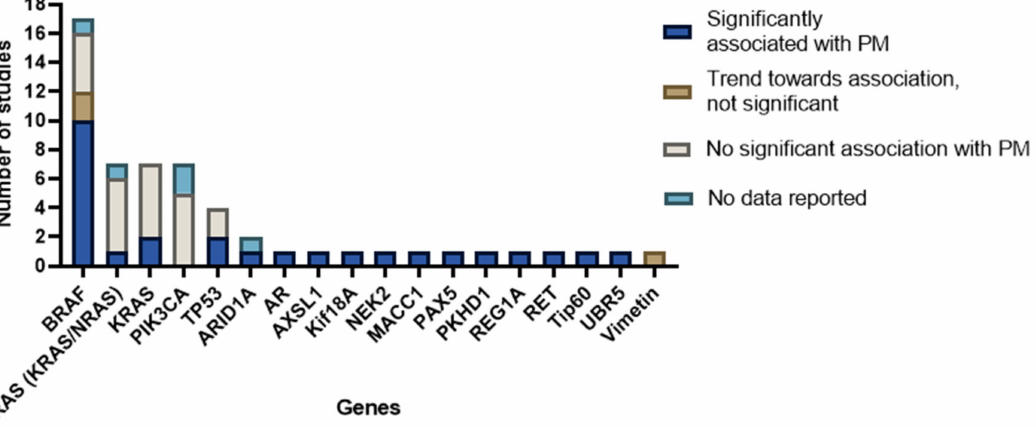
Figure 6. Overview of genes investigated with conclusions formulated by the authors of in- cluded